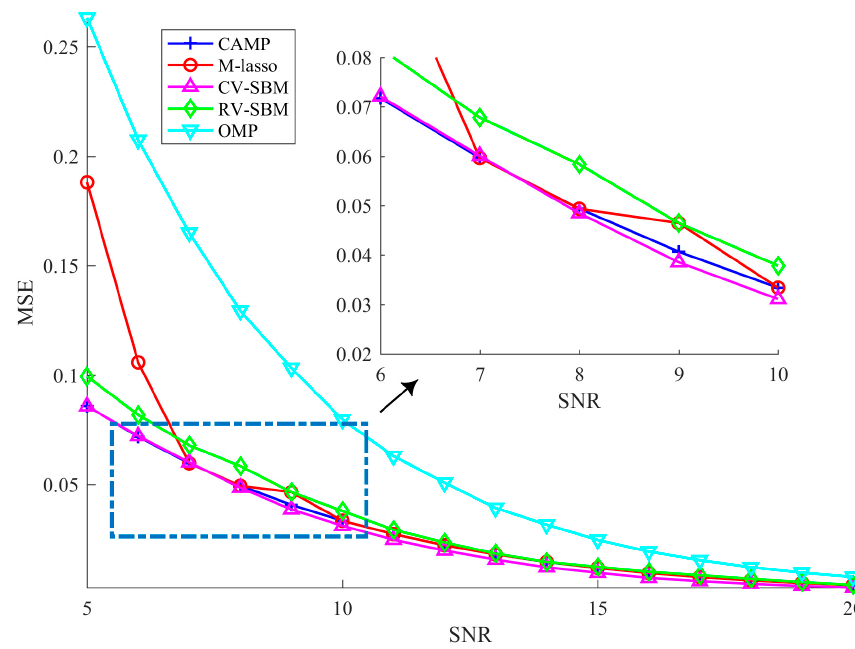
Figure 3. Average MSE in different measurement noise levels.